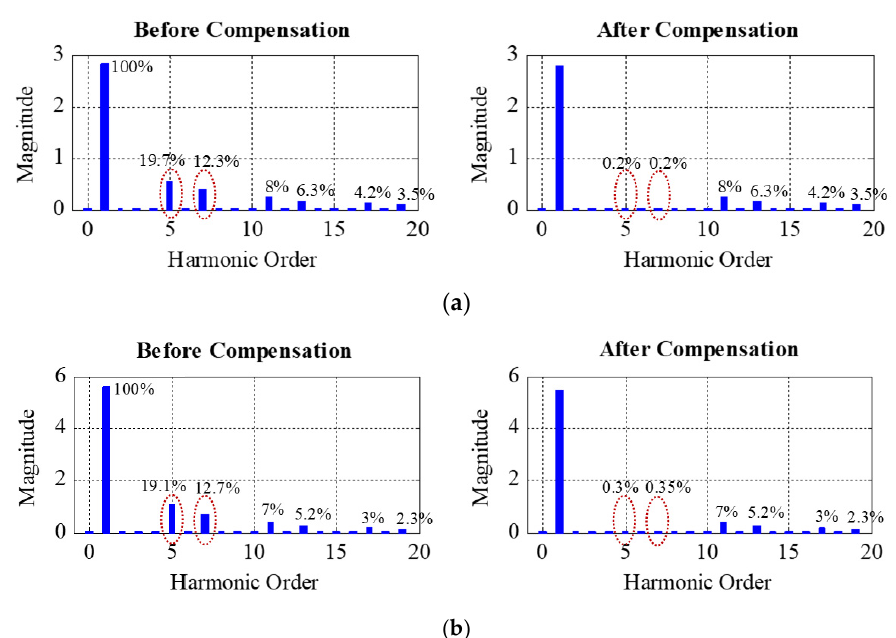
Figure 18. Spectrums of the source current using ADALINE for compensating the harmonic current order 5 and 7: ( a ) Spectrums at intervals 0 ≤ Time < 0.25 s; ( b ) Spectrums at intervals 0.25 ≤ Time < 0.5 s.